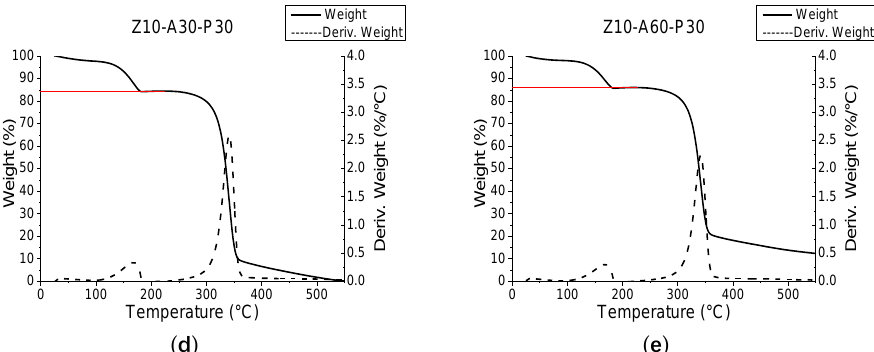
Figure 9. The thermogravimetry (TG) and the derivative thermogravimetry (DTG) curves of the untreated pressboard ( a ); sample Z10-A30-P20 ( b ); sample Z10-A60-P20 ( c ); sample Z10-A30-P30 ( d ); and sample Z10–A60–P30 ( e ).